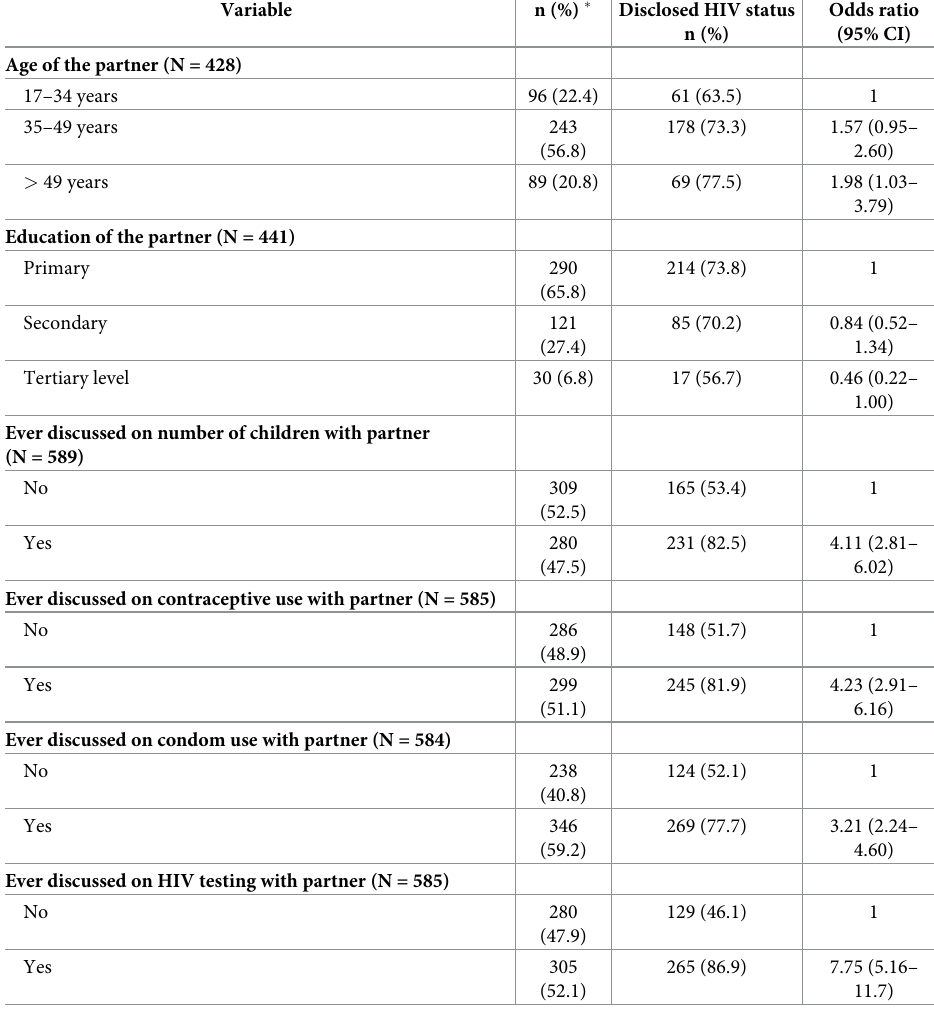
Table 2. Partners and couple communication characteristics associated with disclosure in Kilimanjaro (N =